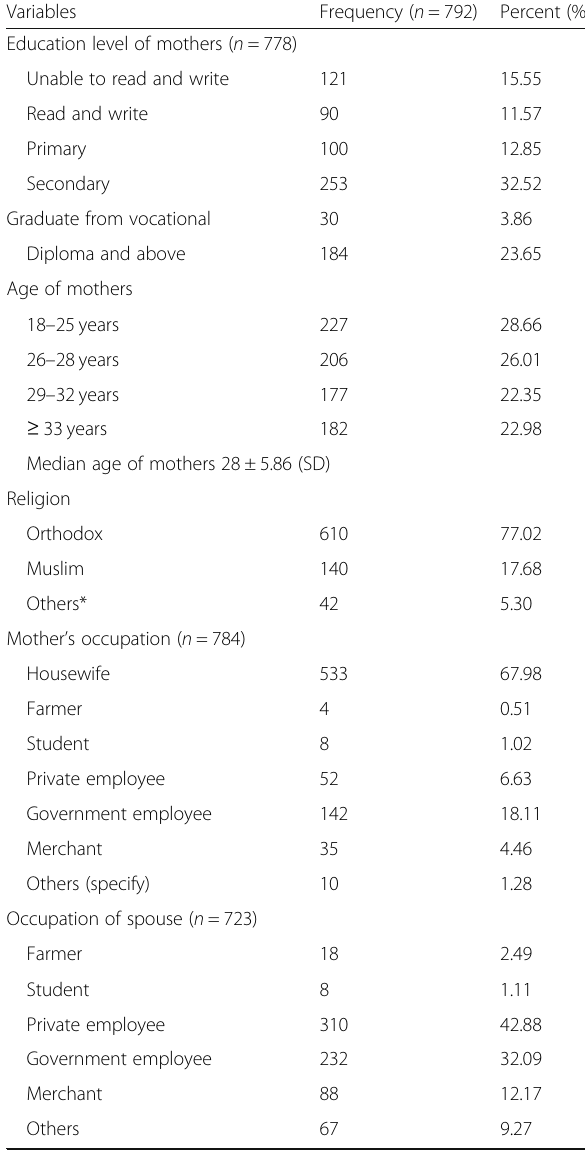
Table 1 Sociodemographic characteristics of study participants in Gondar city, northwest Ethiopia,